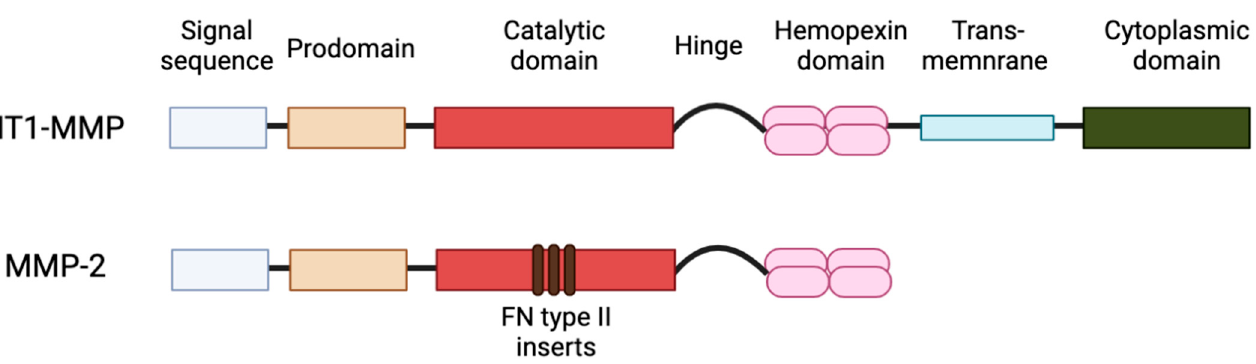
Figure 1. Structure of MMP domains of a membrane-type (MT1-MMP) and a gelatinase (MMP-2) member of MMPs. MT1-MMP has transmembrane and cytoplasmic domains that are absent in MMP-2. MMP-2 has fibronectin (FN) type-II inserts within its catalytic domain.